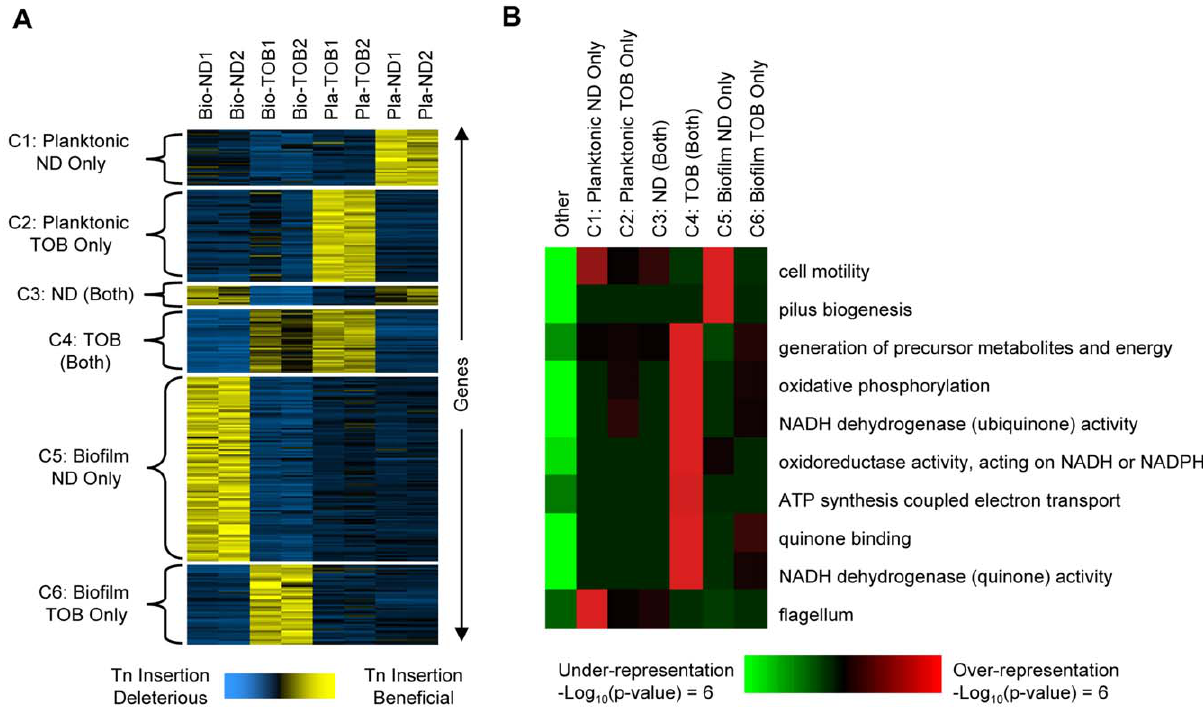
Figure 2. Gene- and pathway-level analysis of fitness profiles. Comparative analysis of genome-wide footprinting data suggests that transposon insertions in or near 586 genes (see Dataset S3 for a complete list of these genes) cause reproducible, condition-dependent behavior that increases fitness in at least one setting (see Protocol S1). (A) The 586 genes (rows) were arranged using K-means clustering into six clusters shown on the left (C1 through C6). The hybridization scores shown for each gene were mean-centered and normalized to a standard deviation of one. This commonly used normalization puts each gene’s fitness profile on a similar scale and facilitates comparison between the different conditions. Yellow indicates those conditions where mutants with transposons in or near the indicated gene underwent the greatest increases in abundance. Blue indicates conditions where transposons in or near the same gene were either deleterious or were slightly beneficial and resulted in a comparatively small increase in abundance. Column labels indicate the experimental condition: Bio-ND and Bio-TOB refer to transposon insertion libraries grown as biofilms and treated with no drug or tobramycin, respectively, and Pla-ND and Pla-TOB refer to libraries grown planktonically without or with tobramycin. Two biological replicates were performed in each condition and numbers indicate the repetition number. Gene names and annotations are in Dataset S3. (B) iPAGE was used to look for enrichment and depletion of functional categories (rows) among clusters C1 through C6 plus the set of genes not in any cluster (columns). Red (green) indicates that genes in the cluster were enriched (depleted) for the indicated